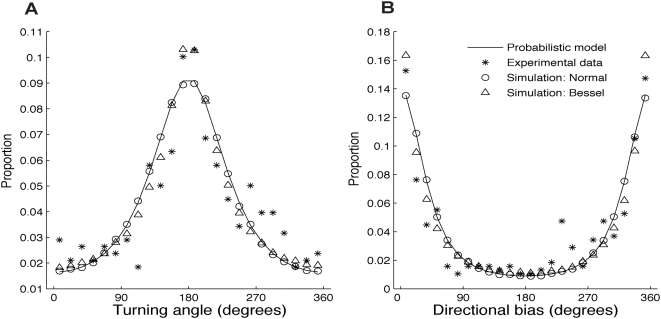
Distributions of measured (A) turning angles and (B) directional biases for stationary animals.The proportion of measured (A) turning angles and (B) directional biases for each 15° interval from 0° to 360° for the stationary collar data (*, n = 406), the probabilistic models (Equations 6 and 7, solid line), and computer simulations with Normal (σ = 4.80, ○) and Bessel (ρ = 0.303, Δ) with M = 0 where 100,000 measured turning angles and directional biases were generated.